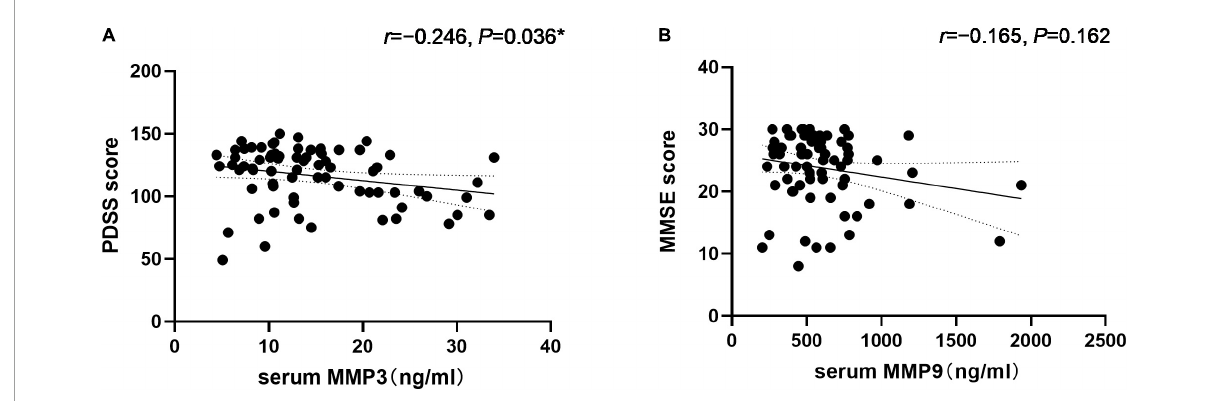
FIGURE4 Correlation of serum Matrix Metalloproteinase 3 (MMP3) with the PDSS score and matrix metalloproteinase 9 (MMP9) levels with the MMSE score in PD patients. (A) Serum MMP3 levels were negatively correlated with the PDSS score (Spearman’s correlation coefficient r = –0.246, P = 0.036, and n = 73). * P < 0 . 05. (B) Serum MMP9 levels were negatively correlated with the MMSE scores (Spearman’s correlation coefficient r = –0.165, P = 0.162, and n = 73) but were not statistically